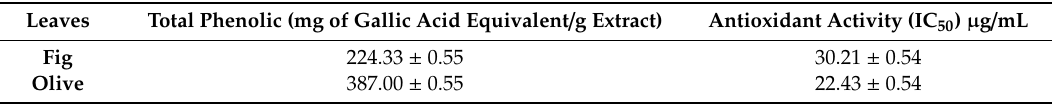
Table 4. Total phenolic compound contents (mg / g) and antioxidant activity (IC50) of fig and olive leaves’ extract.